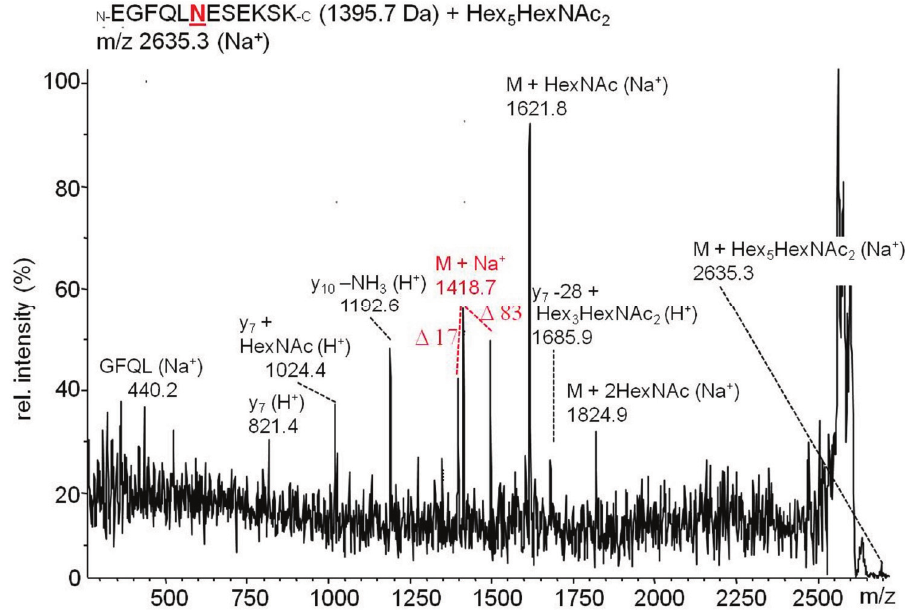
Figure 5. Post-Source-Decay MALDI-MS/MS spectrum of the glycopeptide EGFQLNESEKSK (1395.7 Da) from the molecular chaperone glycoprotein 93 modified with an N -glycan chain (Hex5HexNAc2, H5N2). We identified a series of y-ions, partially modified with N -glycans linked to asparagine within the consensus site NES. The unglycosylated peptide was identified by a triplet of signals representing the peptide mass as sodium adduct accompanied by signals at ´ 17 Da and + 83